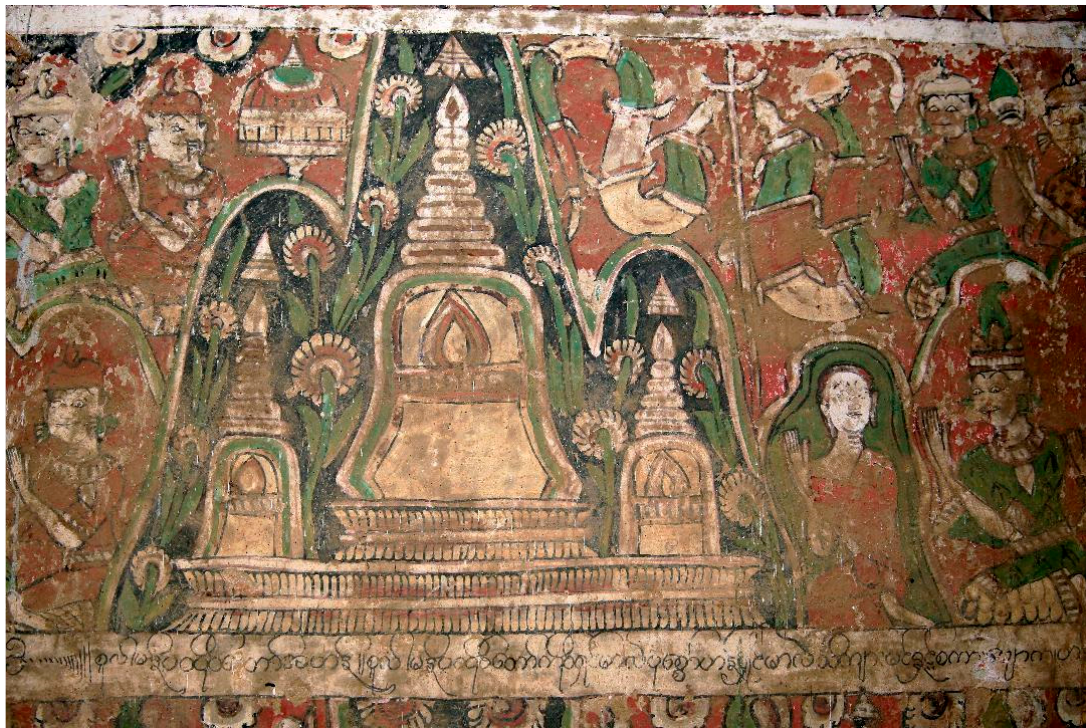
Figure 14. Pakhan nge, Manawyama, 18th century. Shin Malae sweeping Tavatimsa. The gods and Indra make offerings to the Sulamani (Culamani) Hpaya and converse with Shin Malae.